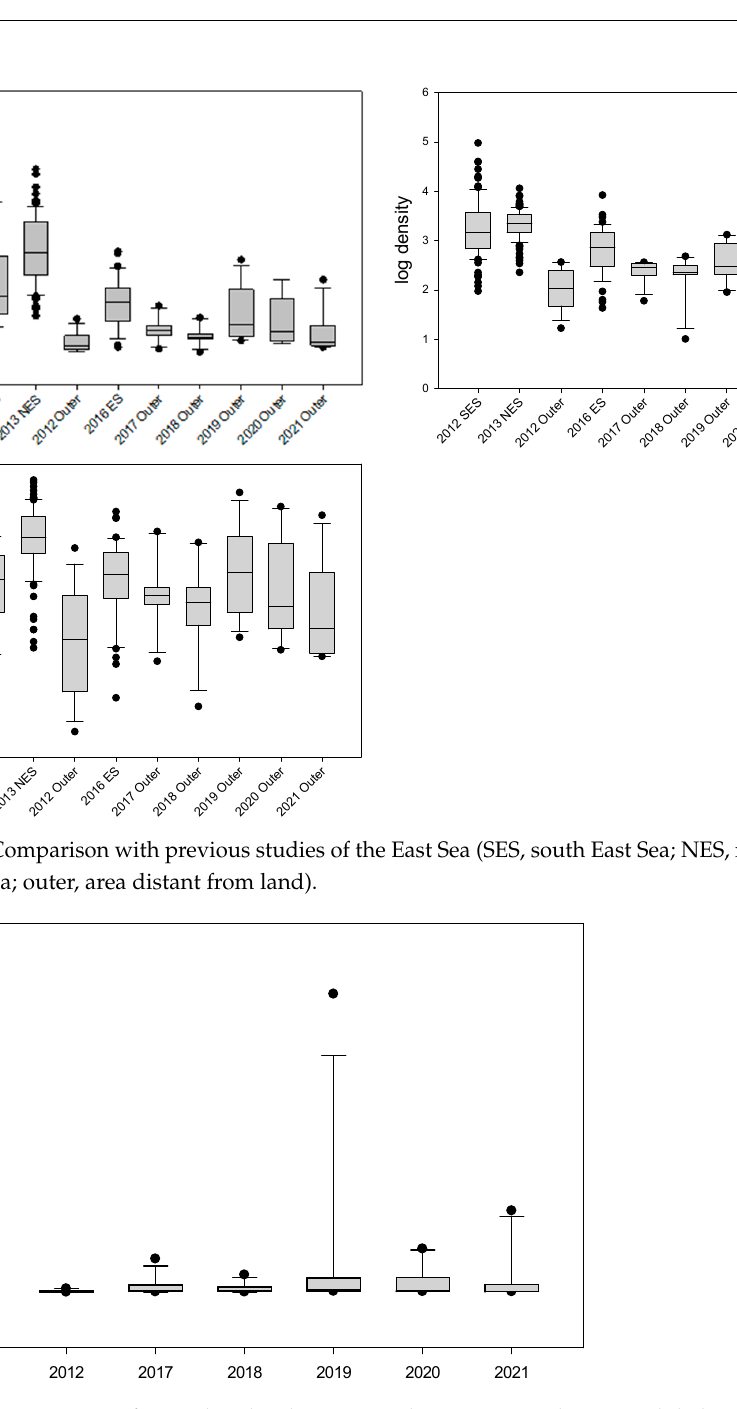
Figure 6. Comparison of macrobenthos biomass with previous studies on Dokdo by year.